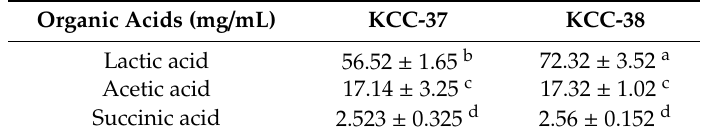
Table 4. Fermentative acids production by L. plantarum KCC-37 and L. plantarum KCC-38 in MRS broth.